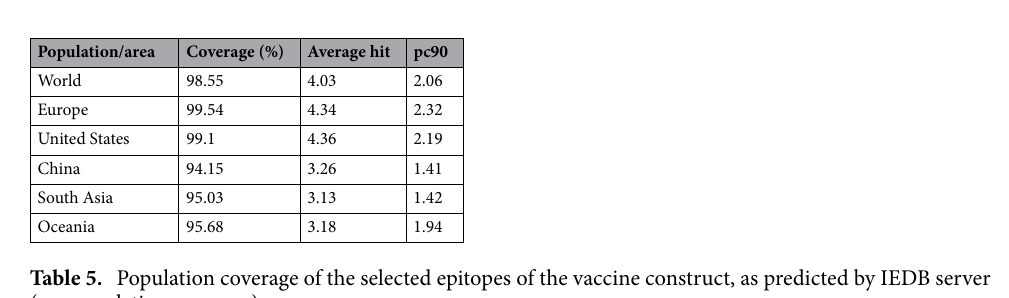
Table 5. Population coverage of the selected epitopes of the vaccine construct, as predicted by IEDB server (pc: population coverage).